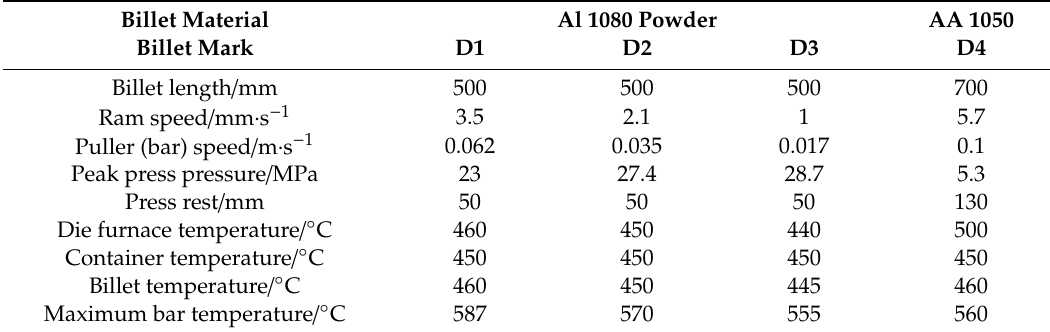
Table 2. Extrusion parameters used for 55 MN direct-extrusion